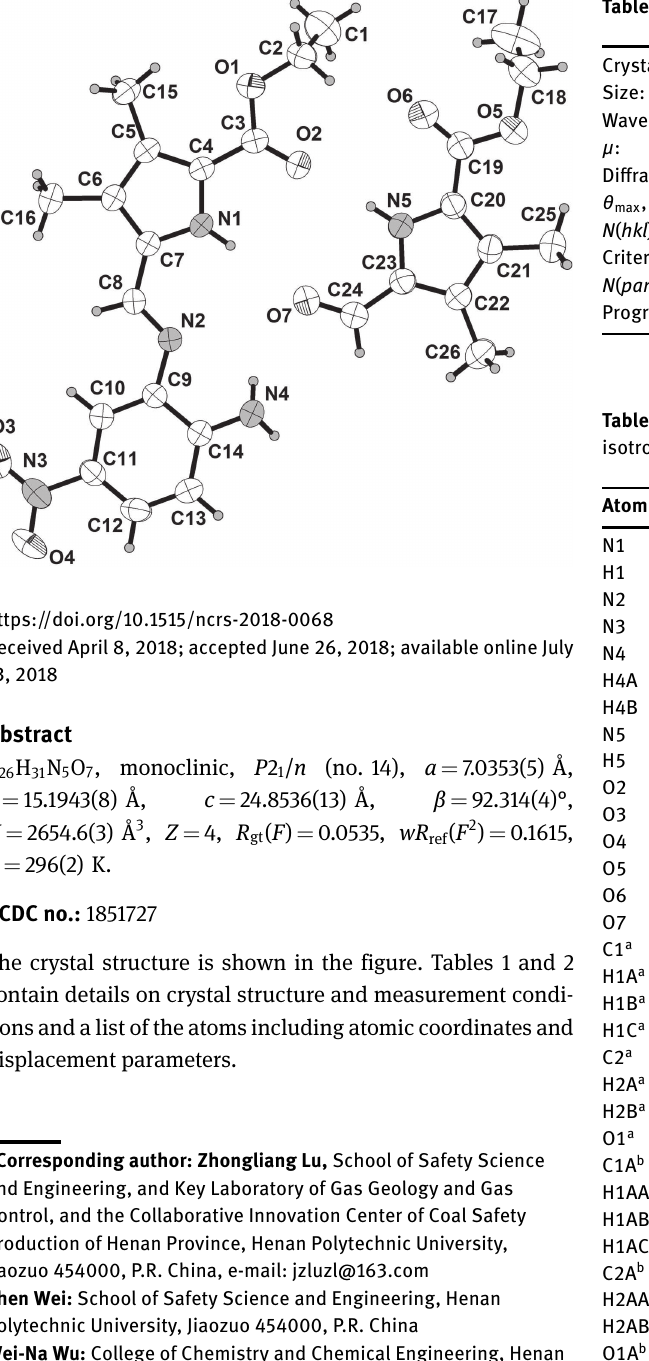
Table 1: Data collection and handling.